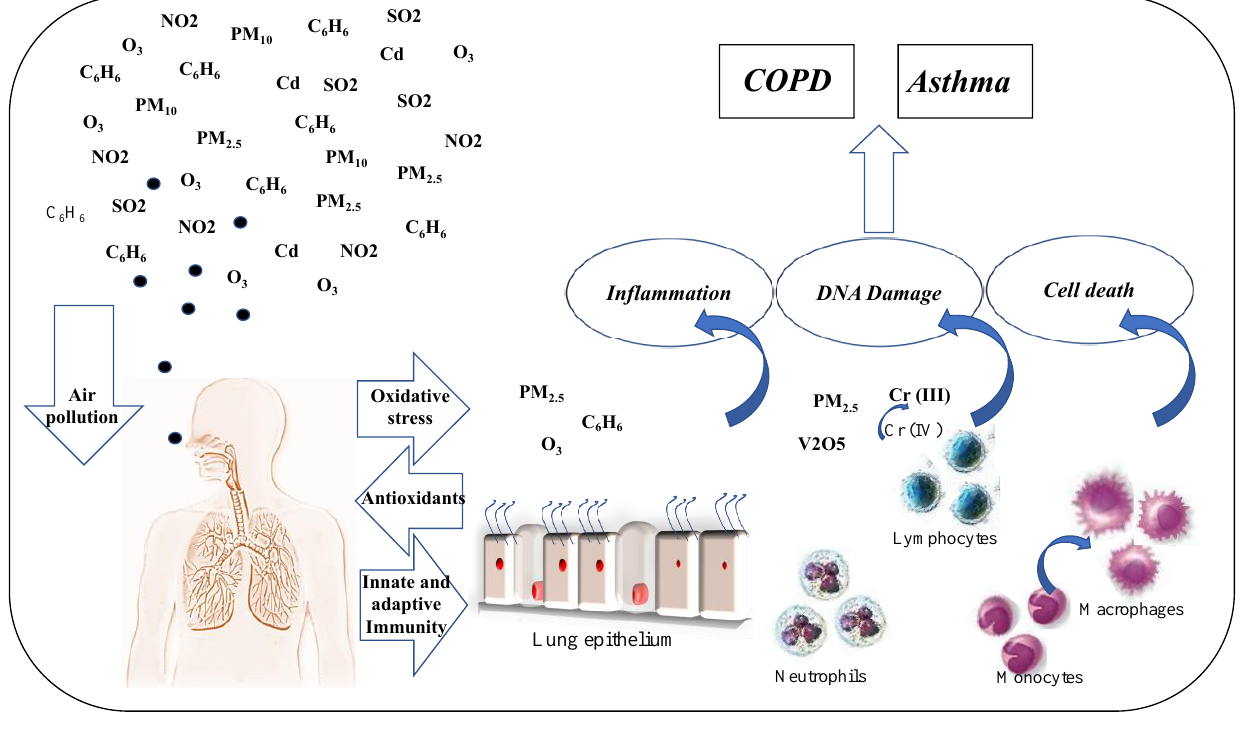
Figure 2. Effects of environmental pollution on OS damaging the activity of immune and structural cells in the airways of patients with chronic inflammatory diseases.